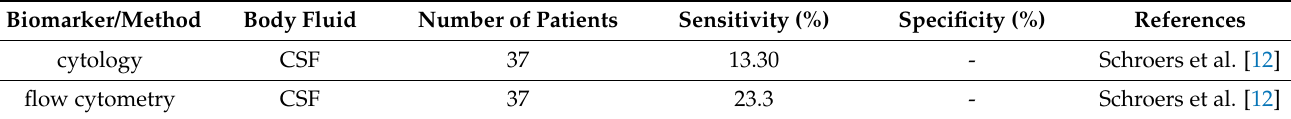
Table 1. Overview of standard diagnostic